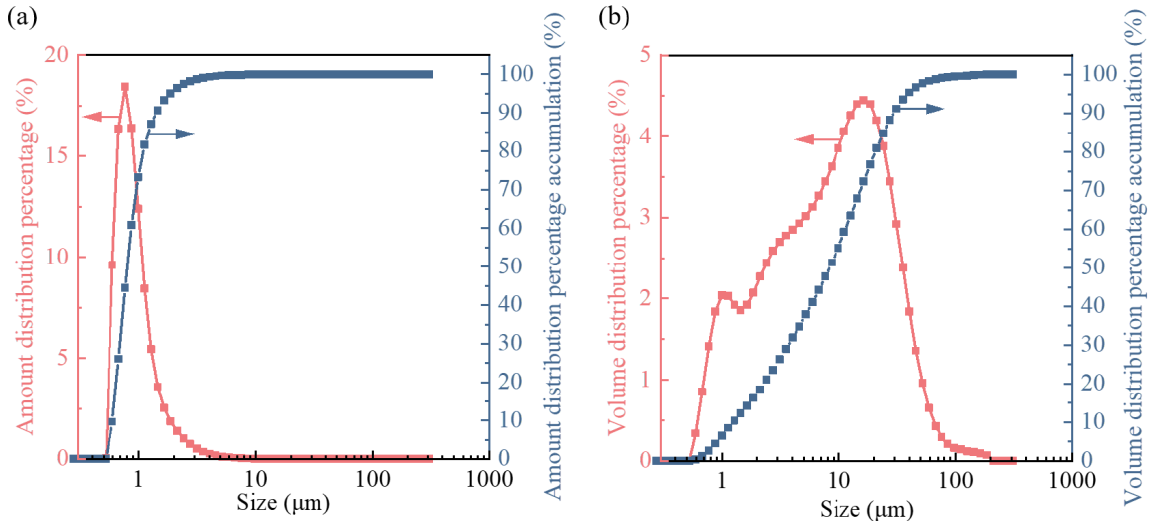
Figure 3. Particle size distribution of oily sludge : ( a ) amount distribution; ( b ) volume